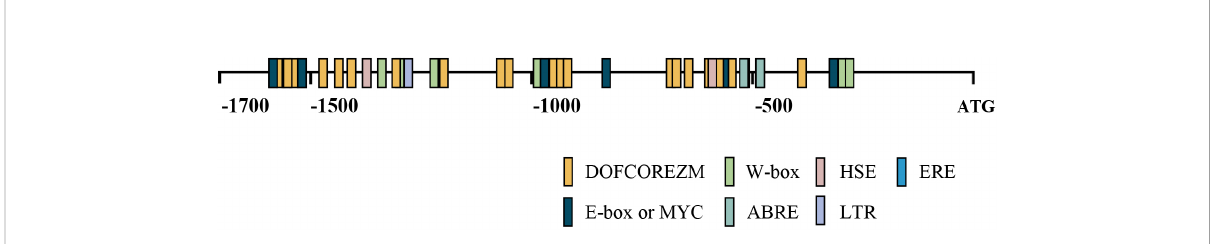
FIGURE 3 Distribution of cis - acting elements in BplMYB46 promoter. The 7 different cis - acting elements in the promoter of BplMYB46 gene are represented in different color